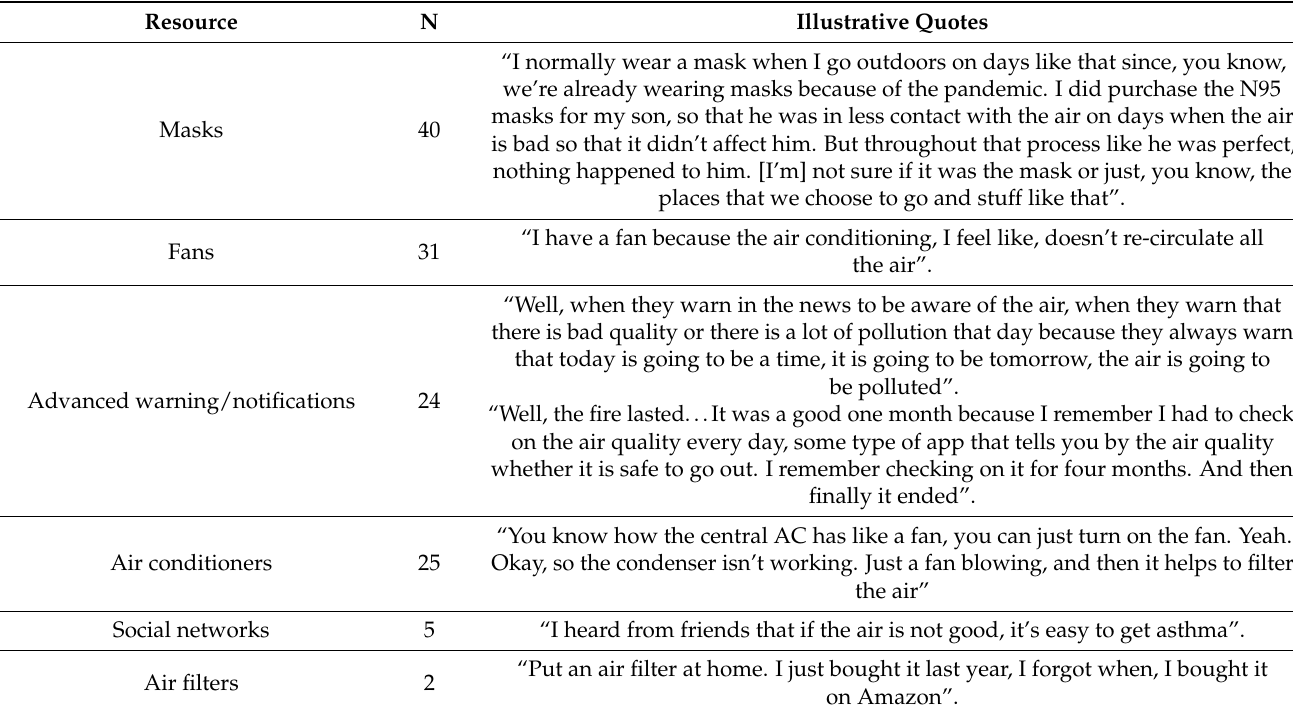
Table 4. Air pollution adaptation